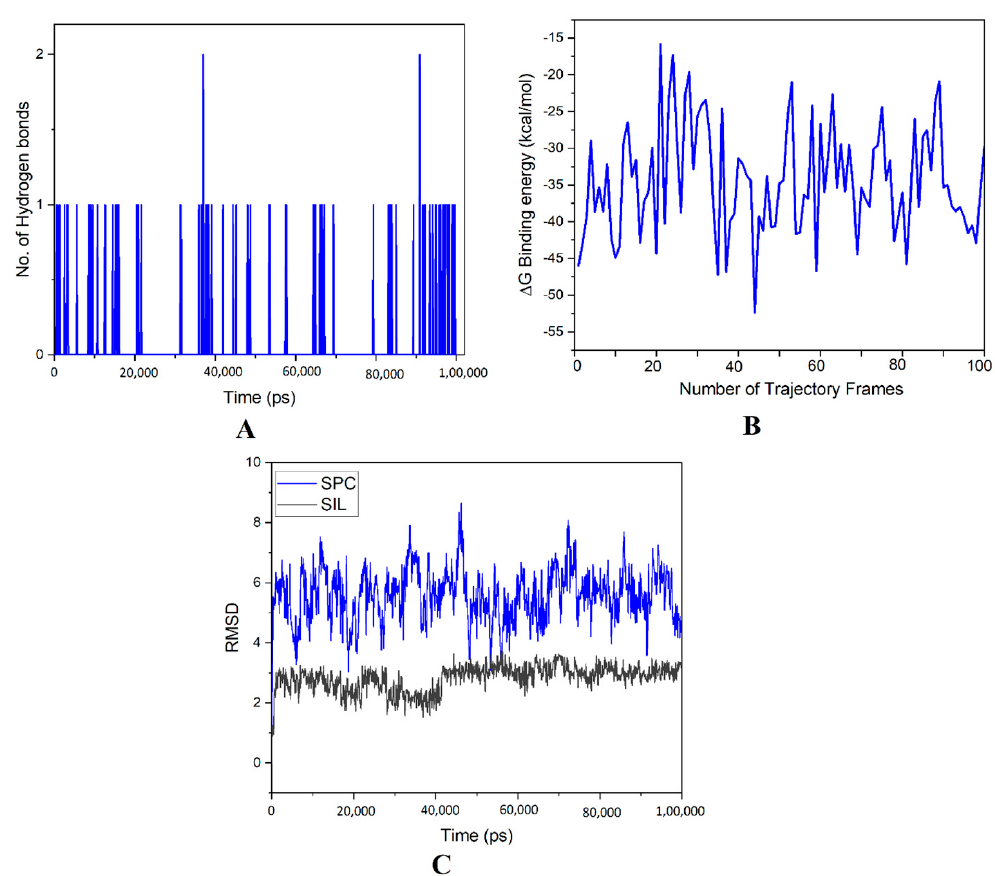
Figure 12. MD simulations of SIL–SPC complex. ( A ) Trajectory frames number; ( B ) hydrogen bonds number; ( C ) root mean square deviation plot.